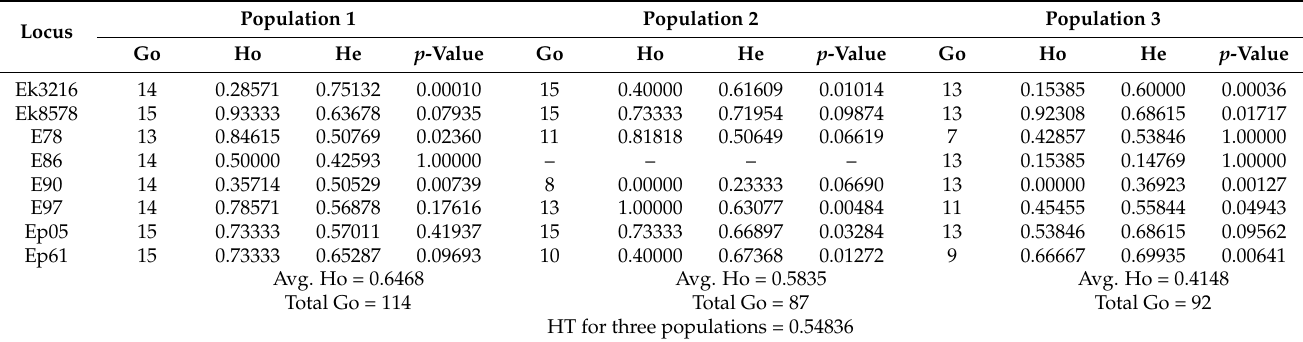
Table 3. Measures of genetic diversity of three populations of Euphorbia fulgens